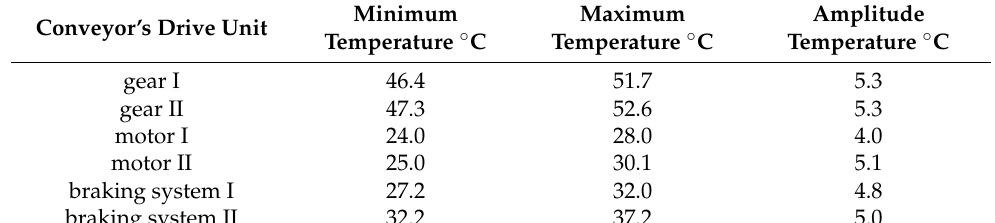
Table 3. Temperature measurement for belt conveyor drive unit PT-4.